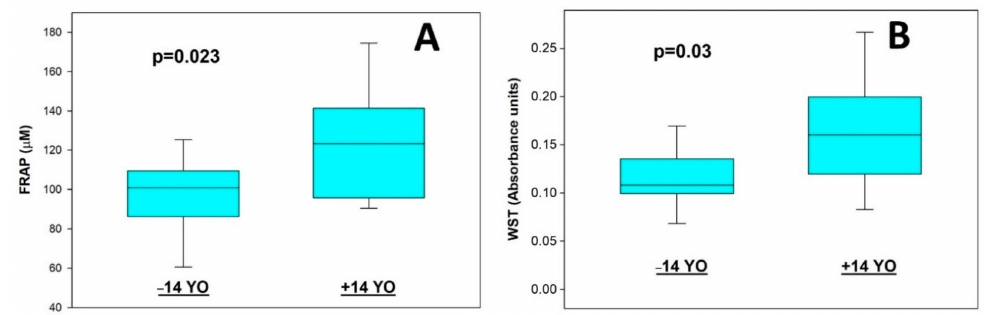
Figure 3. Box plots of the ferric reducing ability of plasma (FRAP) ( A ) and superoxide anion (WST) ( B ) values of the < 14 and > 14-years-old horses belonging to housing category A. The data have been analyzed by Mann–Whitney test.